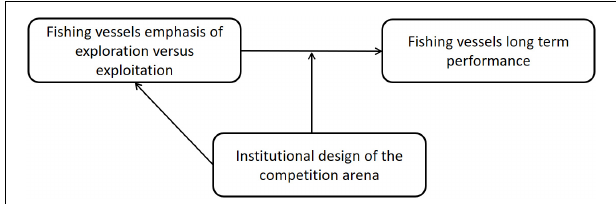
FIGURE 1 | The tentative theoretical framework guiding this